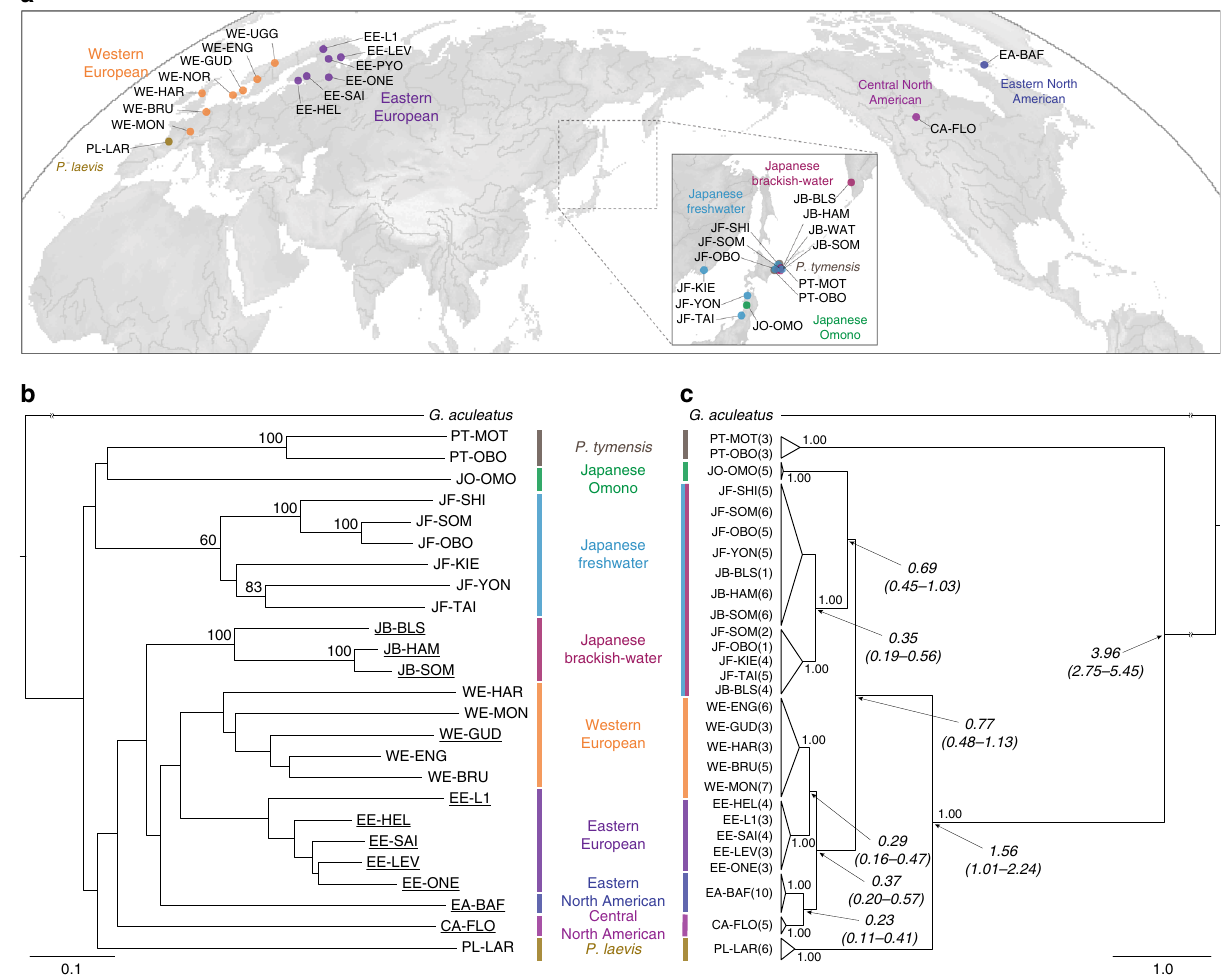
Fig. 1 Phylogenetic relationships among Pungitius populations. a Sampling sites of Pungitius populations and distributions of different lineages used in this study. b Phylogenetic relationships among 25 populations based on 46 autosomal loci. Populations with an XY sex determination system are underlined. Bootstrap values ( ≥ 60) are shown at the nodes. c Mitochondrial phylogeny among 25 populations based on cytochrome b sequences. Posterior probabilities ( ≥ 0.95) are indicated at the nodes. The number of individuals observed in each clade is given in parentheses after the population code. Divergence time estimates (in millions of years) are shown in italics with the 95% highest posterior density interval in F 2 cross between an EE female and a WE male, no signi fi cant association with sex is found for any of the loci across LG12 (Fisher ’ s exact test, P = 0.15 – 1.00; Fig. 2c, f), where no signi fi cant quantitative trait locus (QTL) for sex is found ( F = 7.2 or 4.2,